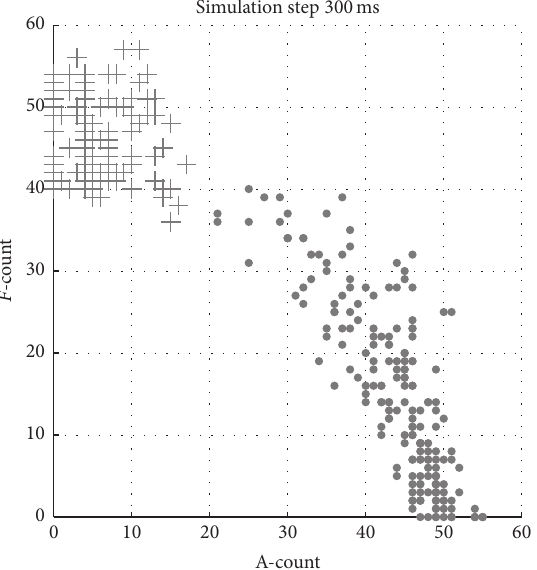
Figure 4: Simulation clusters for the new set of experiments.